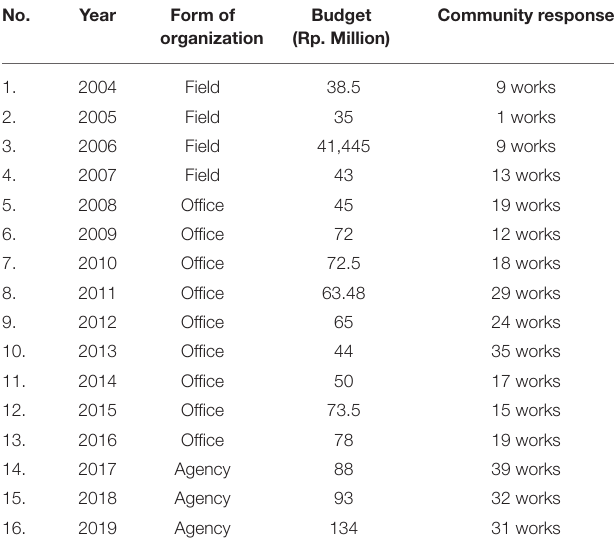
TABLE 1 | Identification of innovation interaction